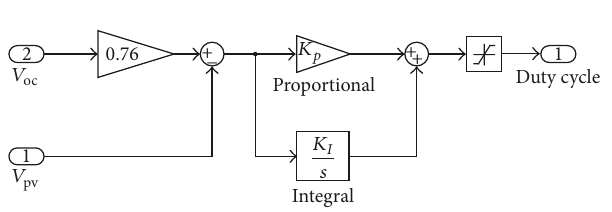
Figure 11: PI controller implementation in Matlab/Simulink.